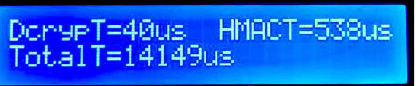
Figure 18. Master node’s decryption, HMAC computing and total time display.